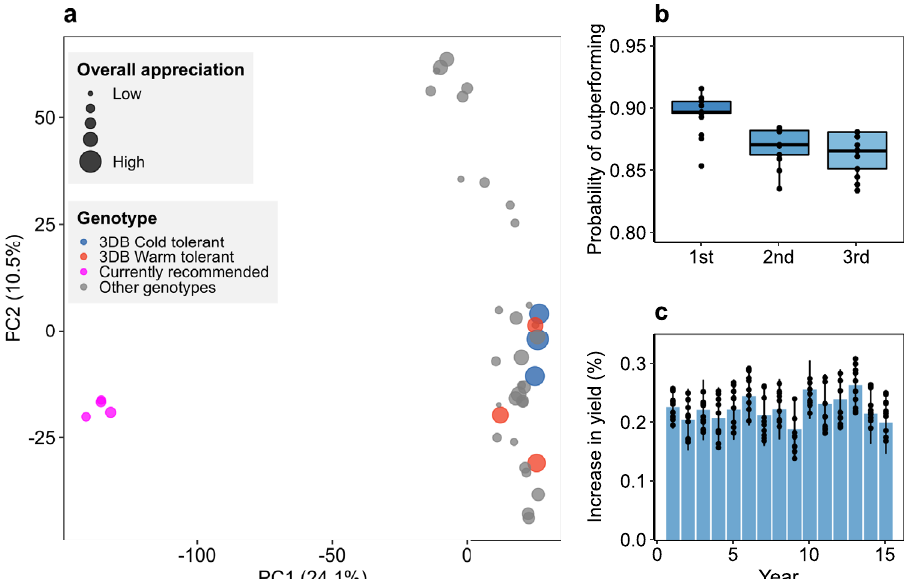
Fig. 2 Selection of durum wheat ( Triticum durum Desf.) genotypes based on 3D-breeding. a Principal component coordinates of the genetic diversity of tested genotypes. Pink dots represent the varieties currently recommended for the area of study. 3DB Cold tolerant (blue) represents the top 3 genotypes selected by 3D-breeding in cold areas (minimum night temperature <11.5 °C). 3DB Warm tolerant (red) represents the top 3 genotypes selected by 3D-breeding in warm areas (minimum night temperature >11.5 °C). Size of dots represents the performance of genotypes in farmer fi elds as overall appreciation (OA). b Probability of outperforming improved varieties currently recommended by using genotype selection generated by 3D-breeding with OA. The panel shows the probability of the top 3 genotypes in a given location in outperforming the improved variety recommended for that location. c Expected increase in yield across 15 consecutive growing seasons (2001 to 2015) for genotype selection from 3D-breeding. n = 1,165